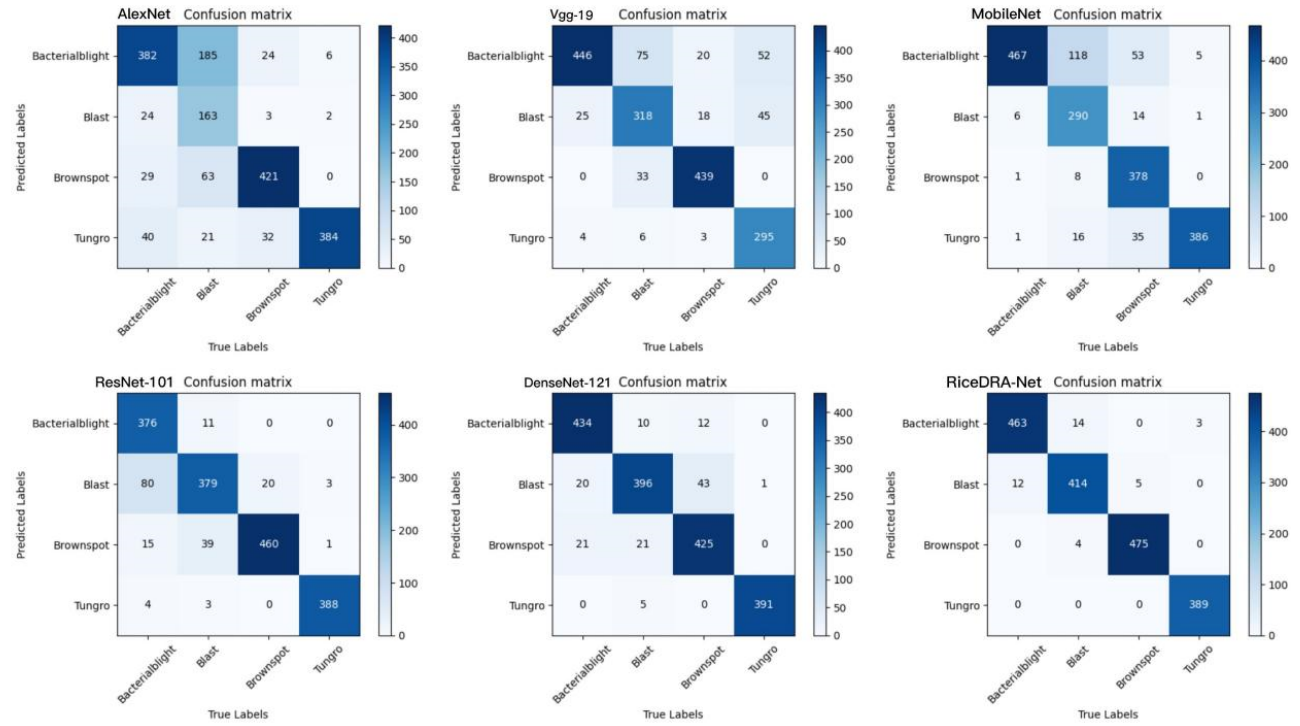
Figure 14. Confusion matrix generated with CBG-Dataset.